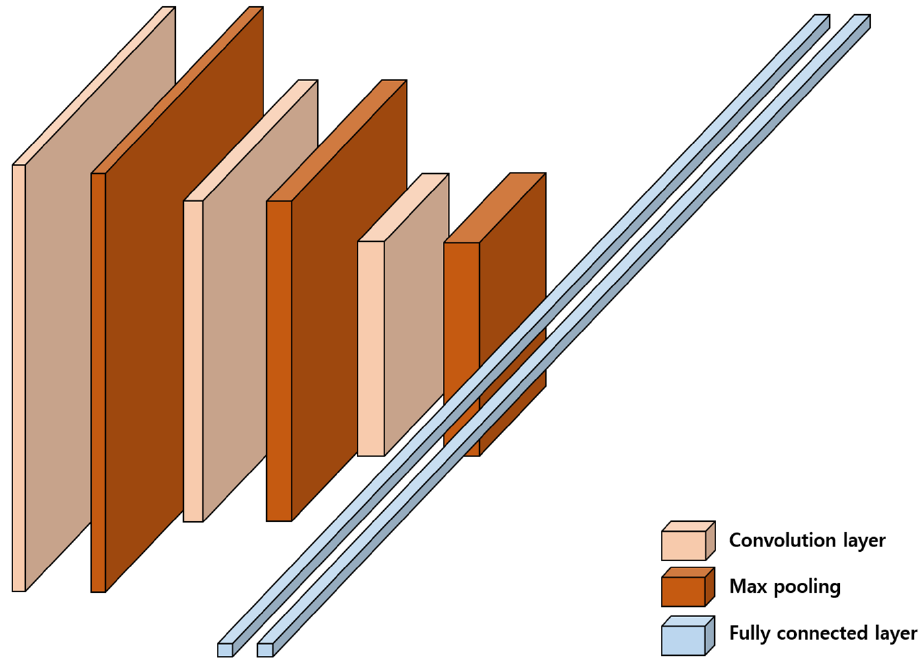
Figure 4. Basic CNN model where number of layers does not include pooling layers. There are three convolutions and two fully connected layers, totaling five layers.